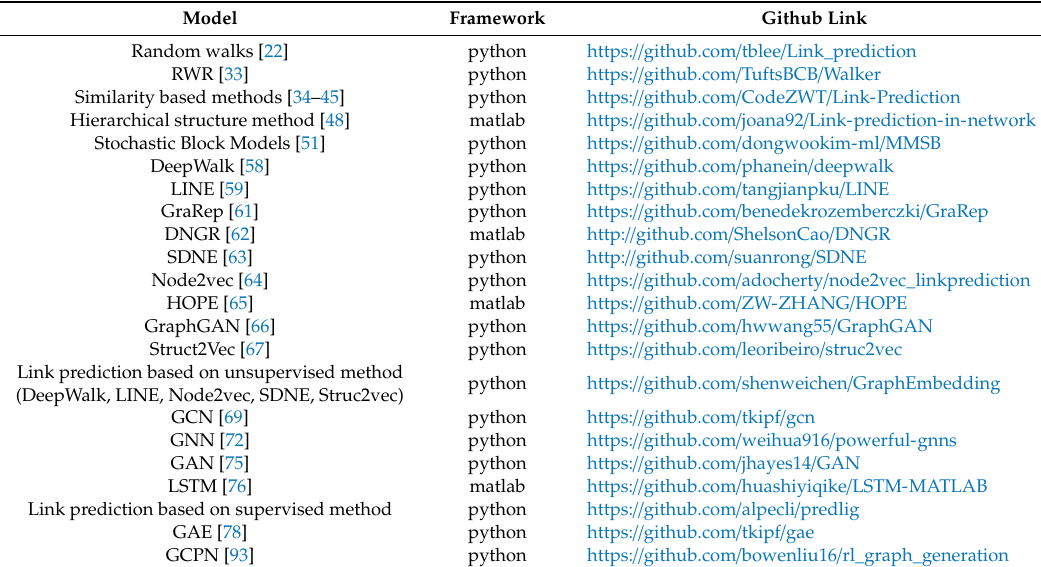
Table 3. A summary of open-source